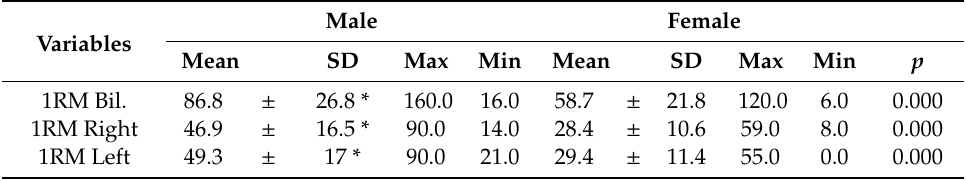
Table 3. Strength values by